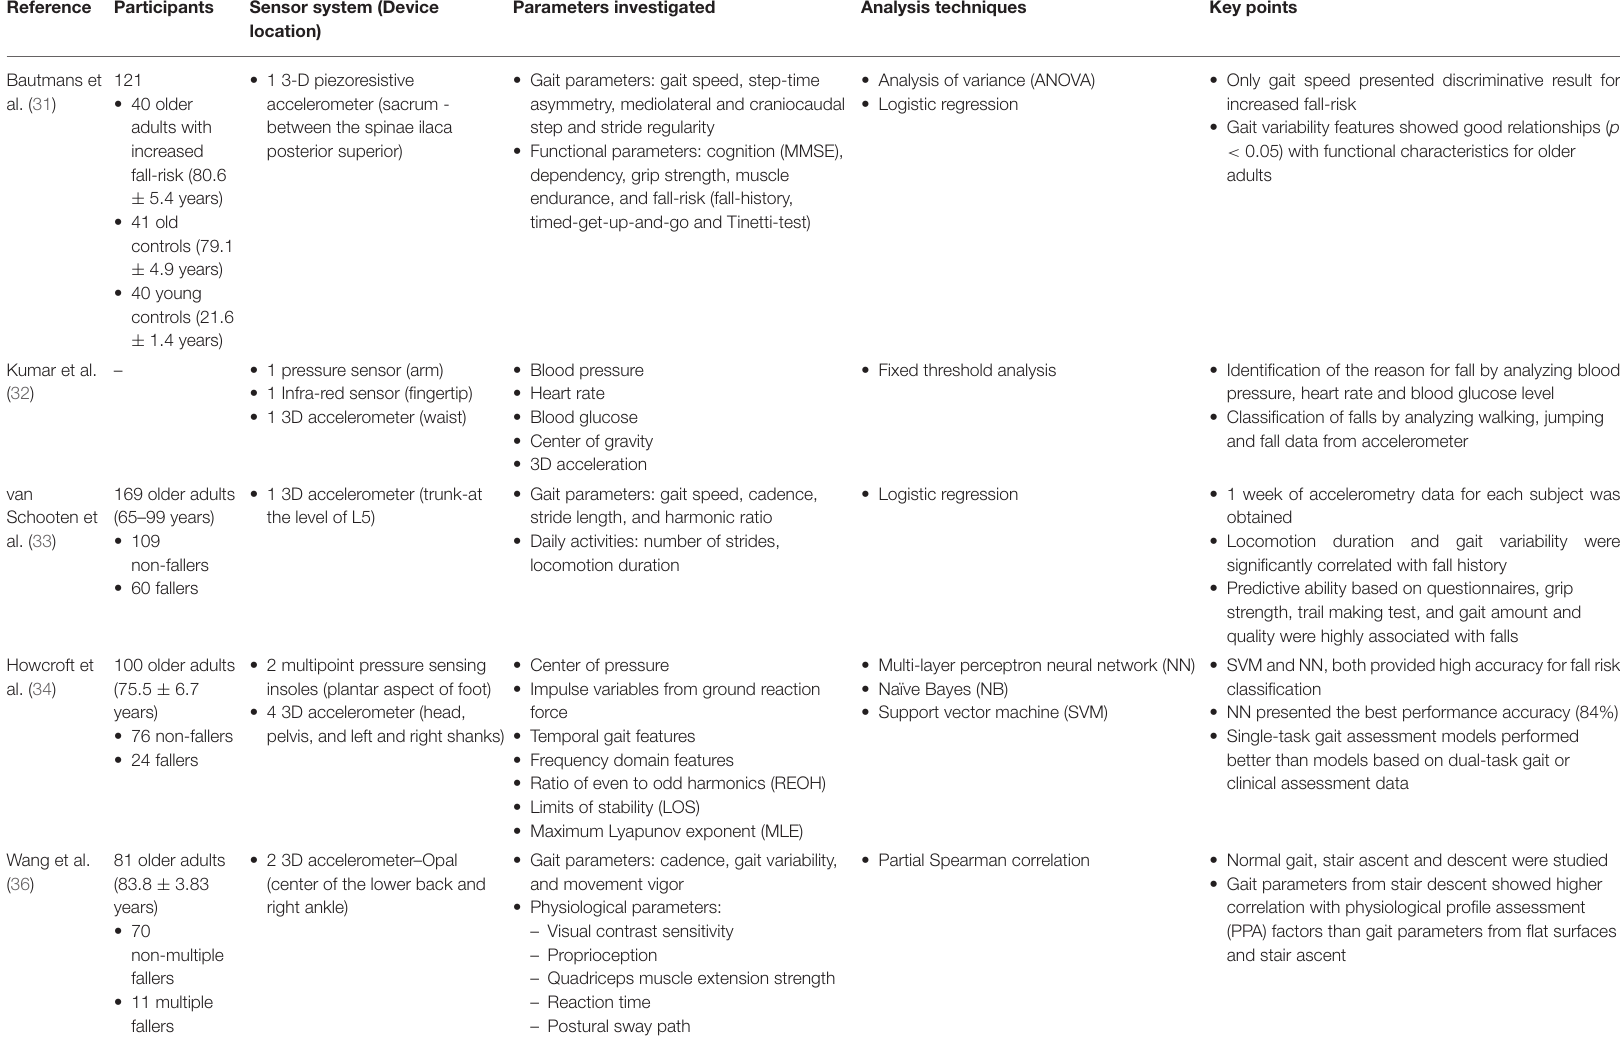
TABLE 1 | Studies using inertial sensor-based fall-risk assessment and fall detection